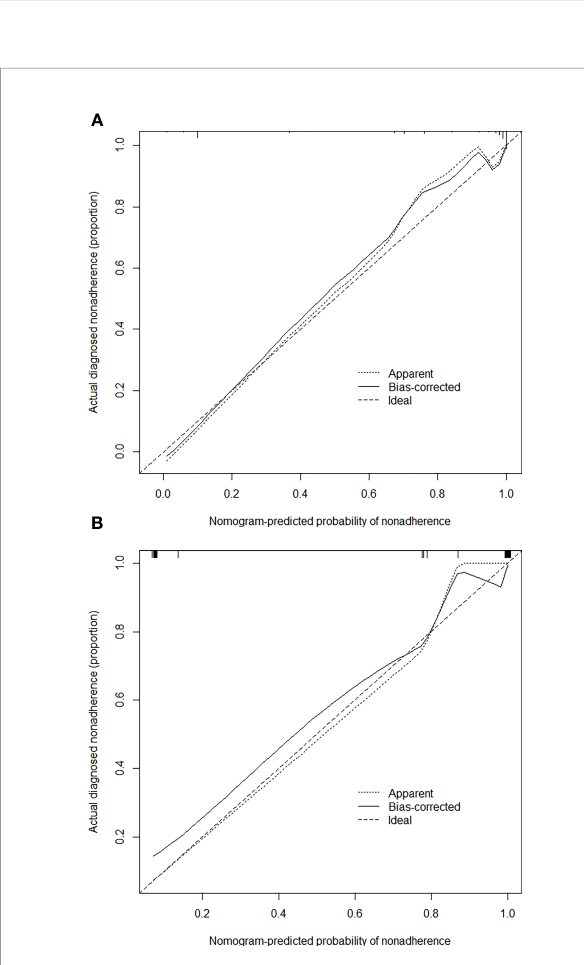
FIGURE 4 | Calibration curves of the nomogram for estimating the malignancy risk in the training (A) and test (B) cohorts. On the calibration curve, the x-axis is the nomogram-predicted probability of malignancy, and the y-axis is the actual probability. The dotted line represents the ideal curve; the small, dotted line is the nomogram curve; and the straight line is the bias- corrected curve.